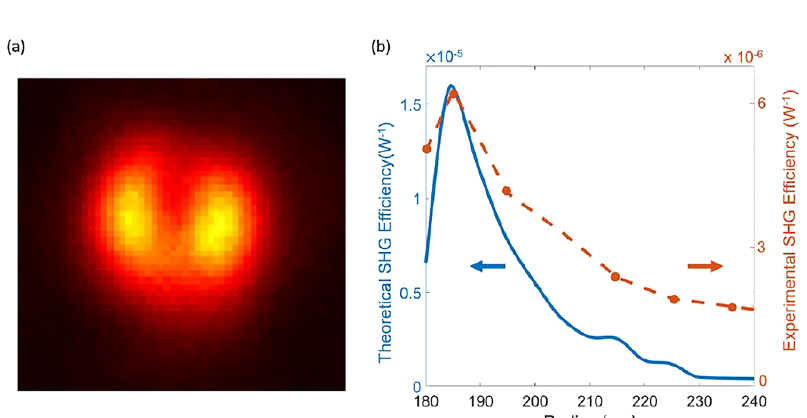
Figure 4: (a) Calculated three-layer meta- surfaces with identical pillar radii r (blue solid curve), three-layer metasurfaces with distributed pillar radii r + 10 nm, r − 10 nm, r − 30 nm (blue dashed curve), and experi- mental (orange line) SHG ef fi ciency vs. nanodisks radius, for p = 1100 nm, (b) Calculated (blue curve) and experi- mental (orange line) SHG ef fi ciency vs. p for apillarradius r =200nm.Anegativeshiftof about 80 nm in the experimental period is added in the fi gure.